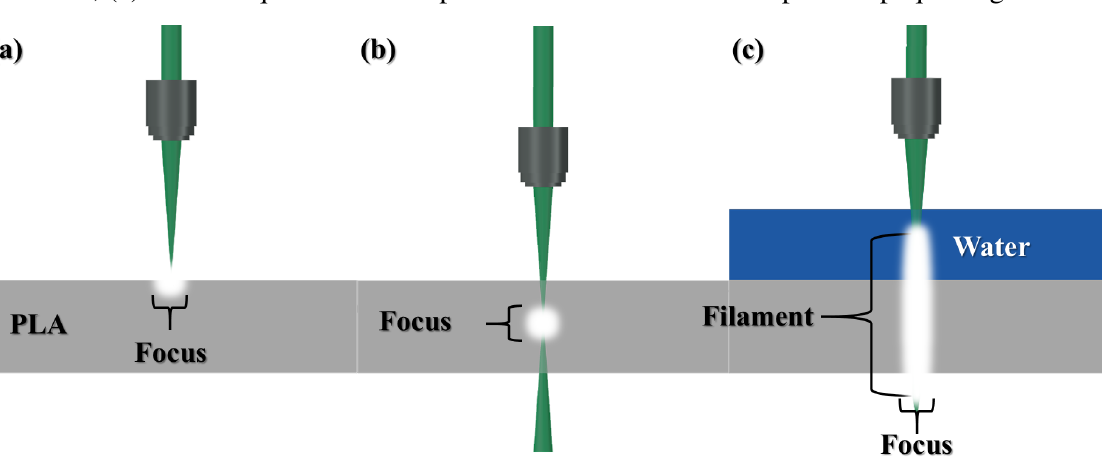
Figure 5. Different laser beam focusing approaches, standard sharp focusing vs. liquid-assisted femtosecond pulsed generated light filaments (FPF): ( a ) focused beam on the surface of the transparent/opaque substrate; ( b ) focused beam in the bulk of the transparent material; ( c ) FPF in liquid-assisted rapid microfabrication of transparent/opaque targets.